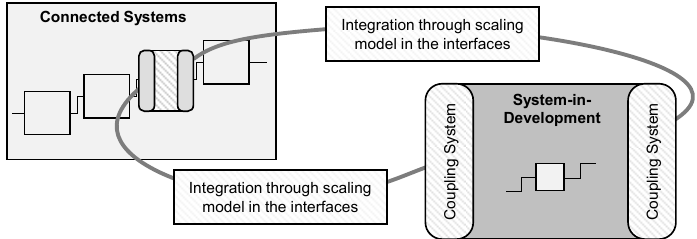
Figure 3. Approach to integrating scaled prototypes into the overall system.